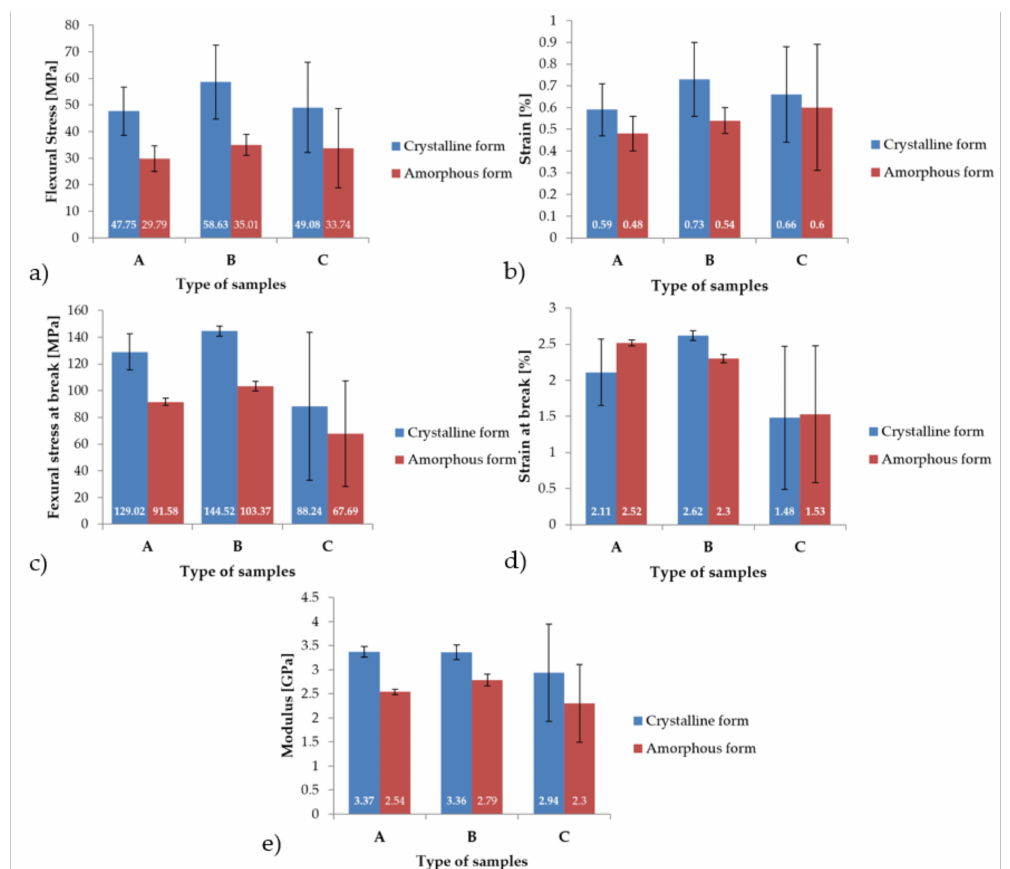
Figure 8. Comparison of the mechanical properties obtained during the three-point bending tests of samples types A, B and C: ( a ) Flexural stress, ( b ) Strain, ( c ) Flexural stress at break, ( d ) Strain at break, ( e ) Modulus of elasticity.